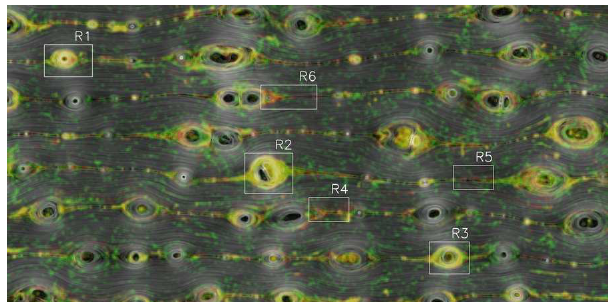
Fig. 6. Evolved 2-D snapshot of magnetic field configuration where Fig. 6. Evolved 2D snapshot of magnetic field configuration where eight parallel Harris current sheets were perturbed in order to trig- eight parallel Harris current sheets were perturbed in order to trig- ger plasma instabilities and reconnection events (represented in grey ger plasma instabilities and reconnection events (represented in grey shades). 10000 test particles, with initial thermal distribution with shades). 10,000 test particles, with initial thermal distribution with temperature corresponding to the sound speed of the MHD model temperature corresponding to the sound speed of the MHD model, were injected in this plasma snapshot to study the acceleration were injected in this plasma snapshot to study the acceleration mechanism induced by magnetic reconnection. The red and green mechanism induced by magnetic reconnection. The red and green colors correspond to regions where either parallel or perpendicu- colors correspond to regions where either parallel or perpendicu- lar acceleration occurs, respectively, while the yellow color shows lar acceleration occurs, respectively, while the yellow color shows locations where both types of acceleration occur. The parallel com- locations where both types of acceleration occur. The parallel com- ponent increases in the contracting islands and in the current sheets ponent increases in the contracting islands and in the current sheets as well, while the perpendicular component increases mostly in the as well, while the perpendicular component increases mostly in the regions between current sheets. The white boxes correspond to the regions between current sheets. The white boxes correspond to the sites where detailed determination of acceleration properties were sites where detailed determination of acceleration properties were done (see text). From Kowal et al. done (see text). From Kowal et al. (2011).